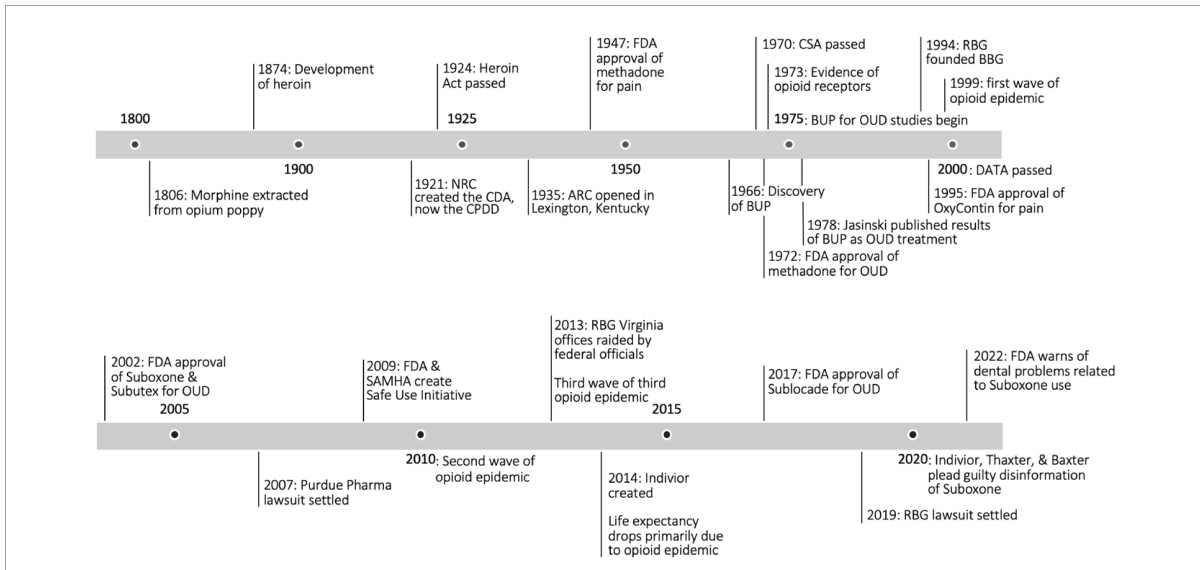
FIGURE1 Opioid timeline. NRC, National Research Council; CDA, Committee on Drug Addiction; CPDD, Committee on Problems of Drug Dependence; ARC, Addiction Research Center; FDA, Food and Drug Administration; BUP, buprenorphine; CSA, Controlled Substance Act; OUD, opioid use disorder; RBG, Reckitt Benckiser Group; BBG, Buprenorphine Business Group; DATA, Drug Addiction Treatment Act; SAMSHA, Substance Abuse and Mental Health Services Administration (2, 5, 13, 31, 43, 45, 47, 48,